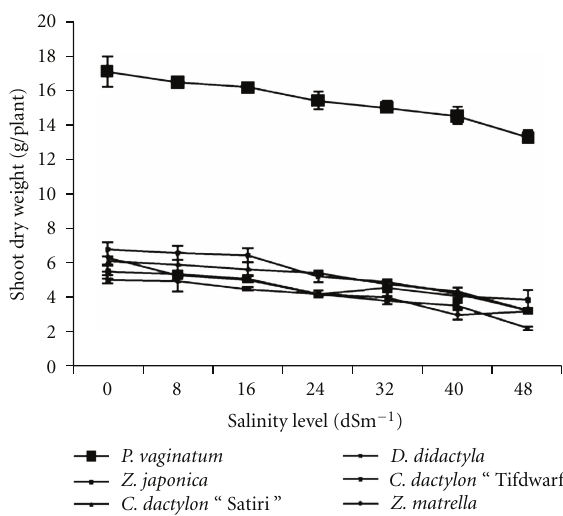
Figure 1: Shoot dry weight at di ff erent salinity levels of six turfgrass species. Figure 2: Root dry weight at di